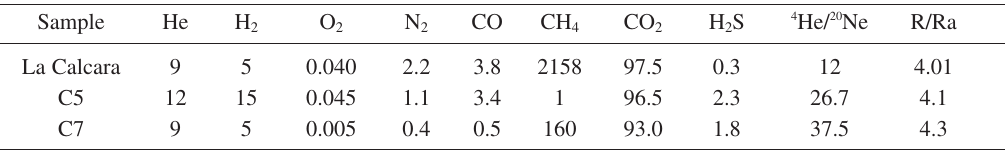
Table I. Chemical composition of the gases sampled during August-September 1996 and estimated equilibra- tion temperature and pressure. The analytical results are expressed in vol% for CO 2 , H 2 S, N 2 and O 2 ; in ppm by vol for He, CO, H 2 and CH 4 . R/Ra = Helium isotopic ratio normalized to the atmosphere (atmospheric 3 He/ 4 He = = 1.39 × 10 − 6 ). na = not analysed. The estimated equilibrium pressures are in bars. Sample He H